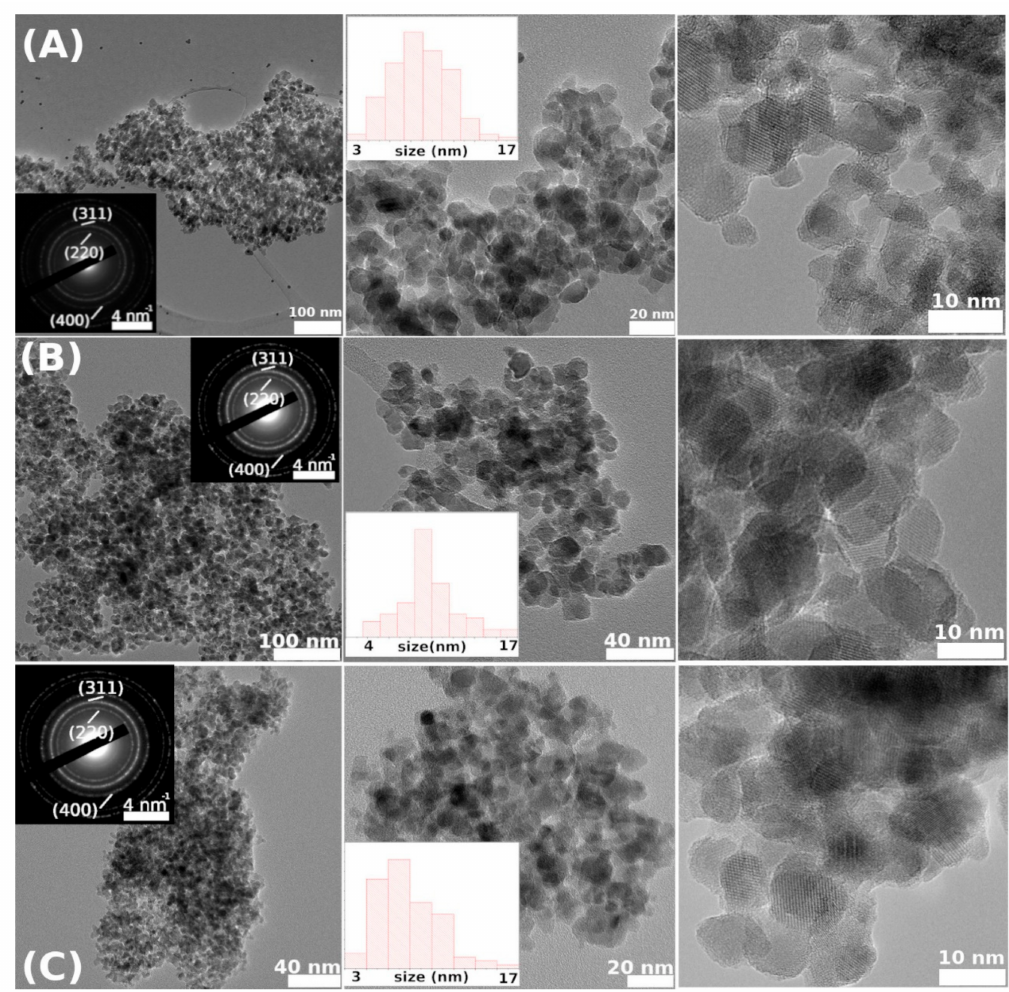
Figure 3. TEM and HRTEM micrographs for samples CFO73 ( A ), CFO83 ( B ), and CFO93 ( C